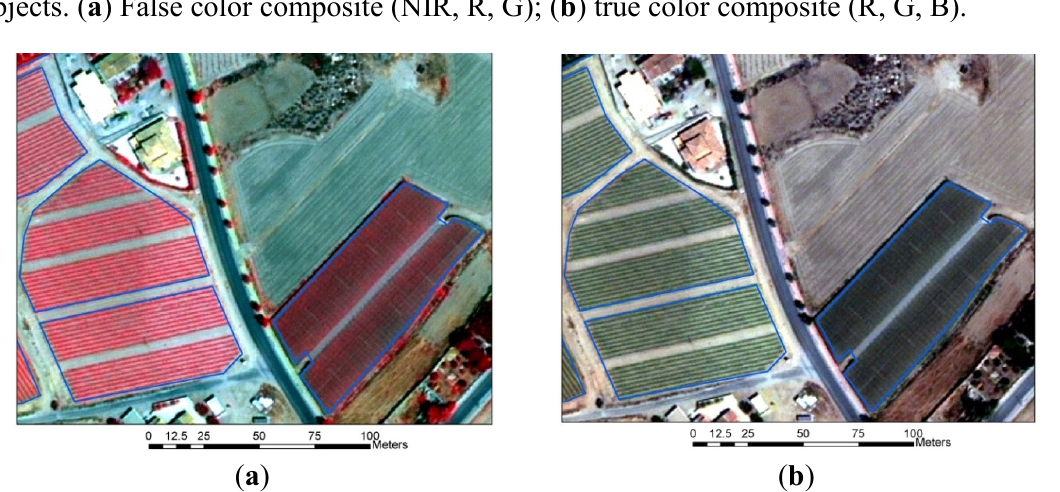
Figure 5. WV10 pan-sharpened orthoimages comparing vegetation with cropped net